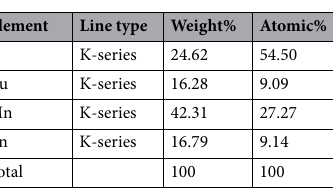
Element Line type Weight%